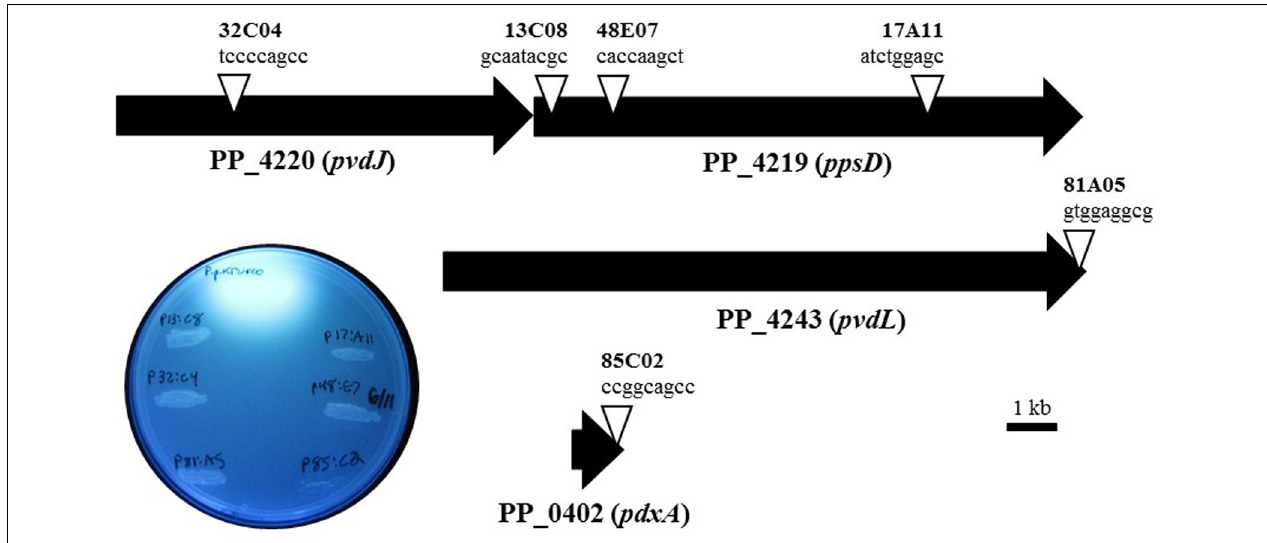
FIGURE 4 | Characterization of transposon mutants of P. putida KT2440 unable to inhibit X. fragariae . The six triangles represent the transposon insertion sites in four genes (PP_4219, _4220, _4243, and _0402) on the KT2440 genome. For each insertion site, the insertion sequence and corresponding mutant label (e.g., tccccagcc, mutant 32C04) are shown. The inset shows the six mutants together with P. putida KT2440 on a UV-illuminated WBN agar plate to show the fluorescence produced by wildtype but not in mutants.